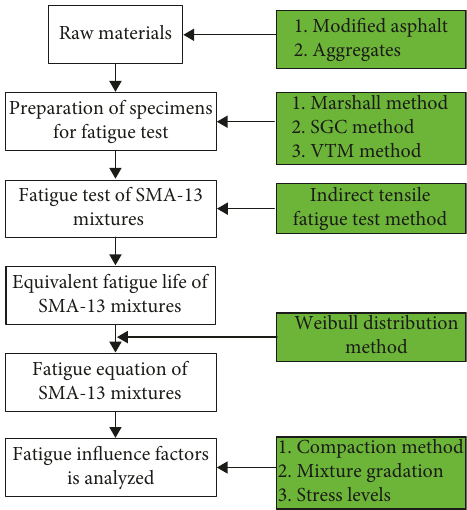
Figure 1: Flowchart of